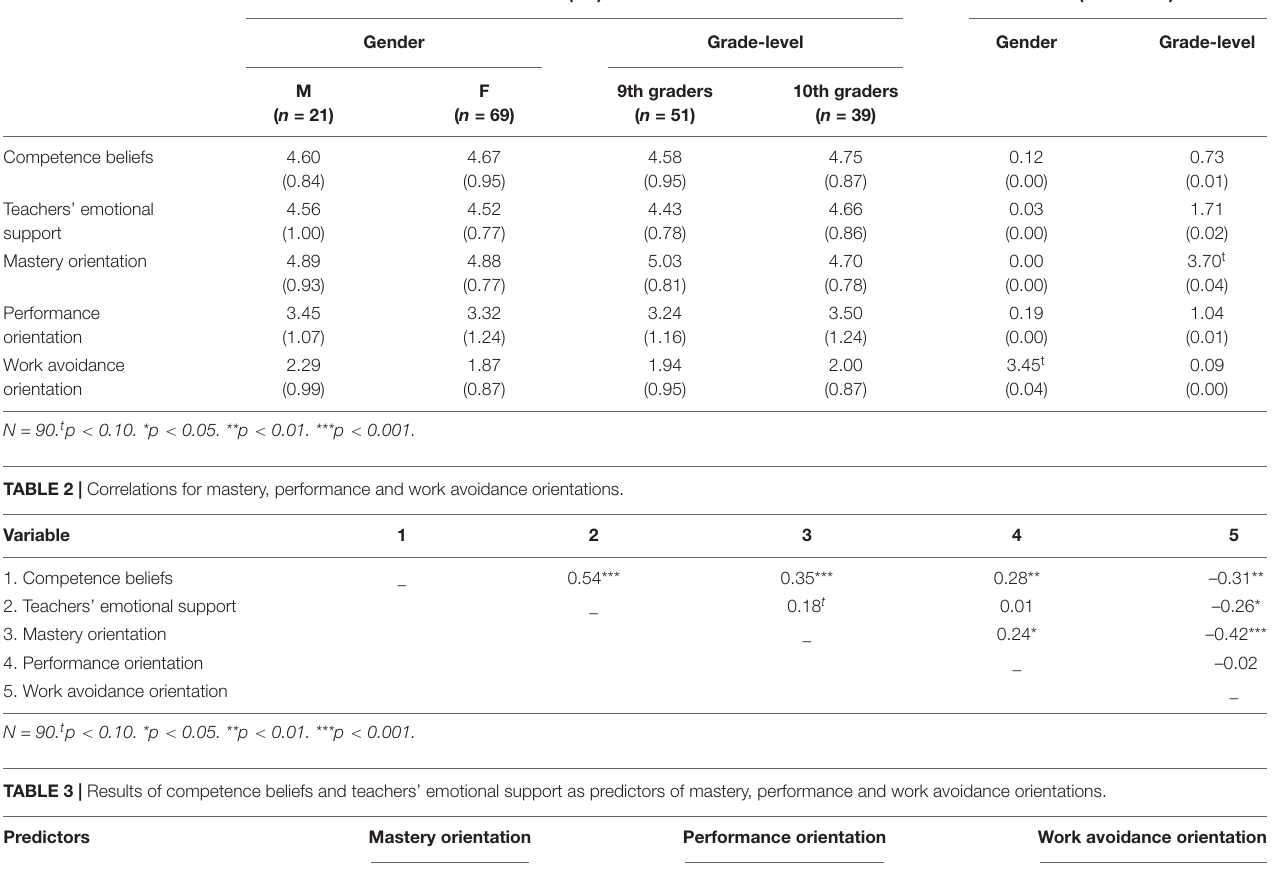
TABLE 1 | Gender and grade-level differences on mastery, performance and work avoidance orientations. Variable